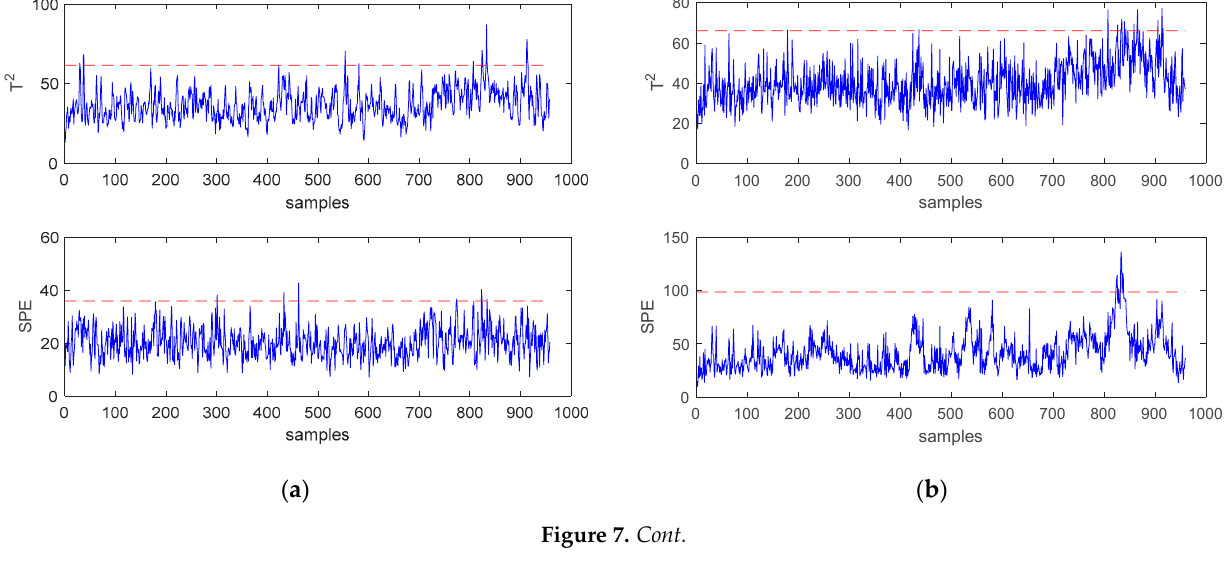
Figure 6. Fault diagnosis diagram of fault 10.